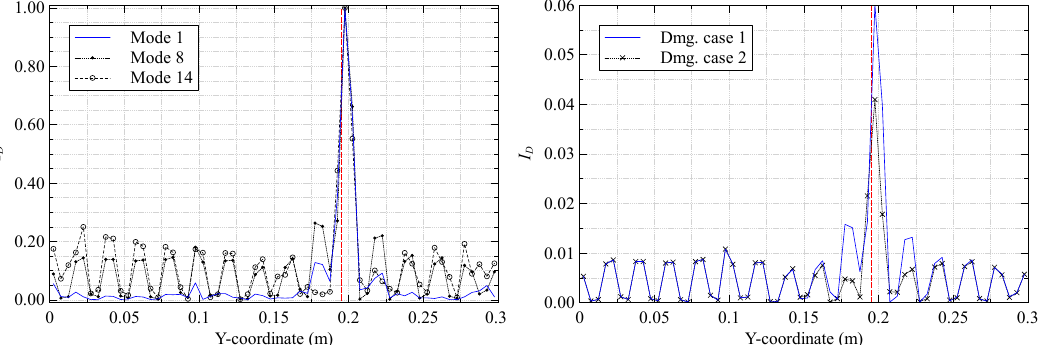
Figure 8. Damage index plots along x = 162.5 mm for ( left ) damage case 1 and ( right ) mode